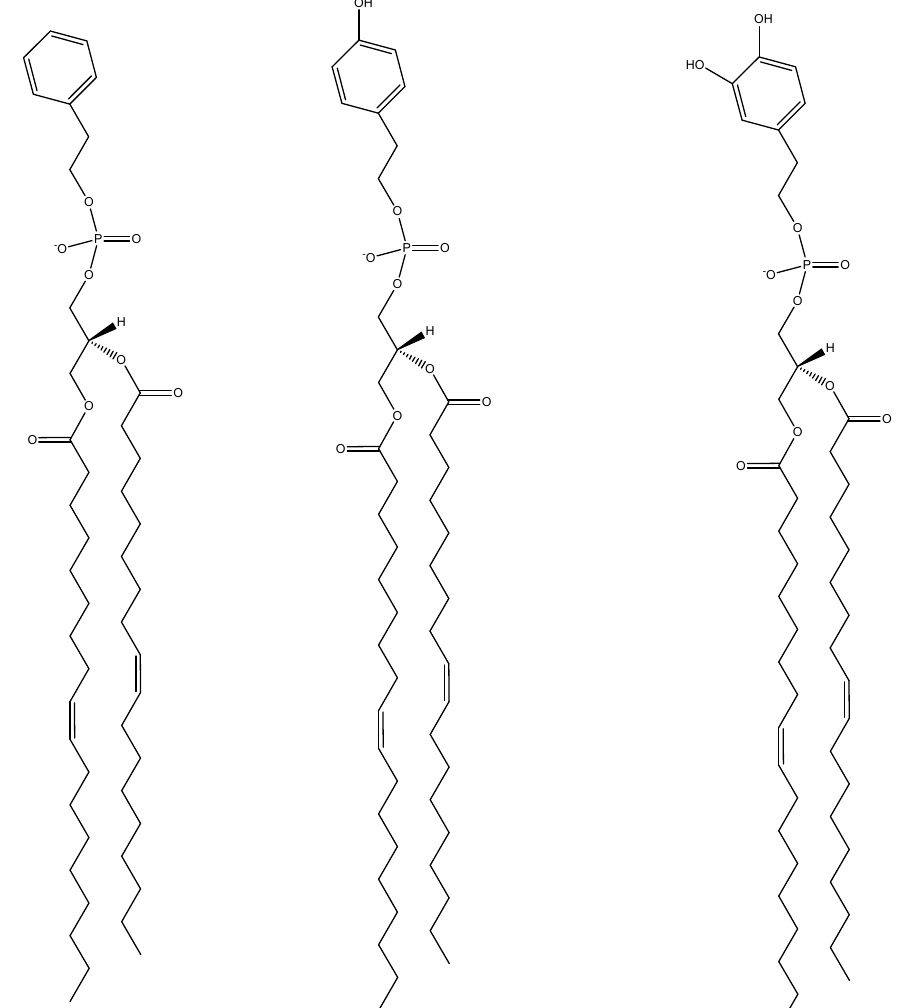
Figure 1. Structural representation of 1,2-dioleoylphosphatidyl-2-phenolethanol (DOPPE), 1,2- dioleoylphosphatidyl-tyrosol (DOPT) and 1,2-dioloeoylphosphatidyl-hydroxytyrosol (DOPHT) (left to right) phospholipids.